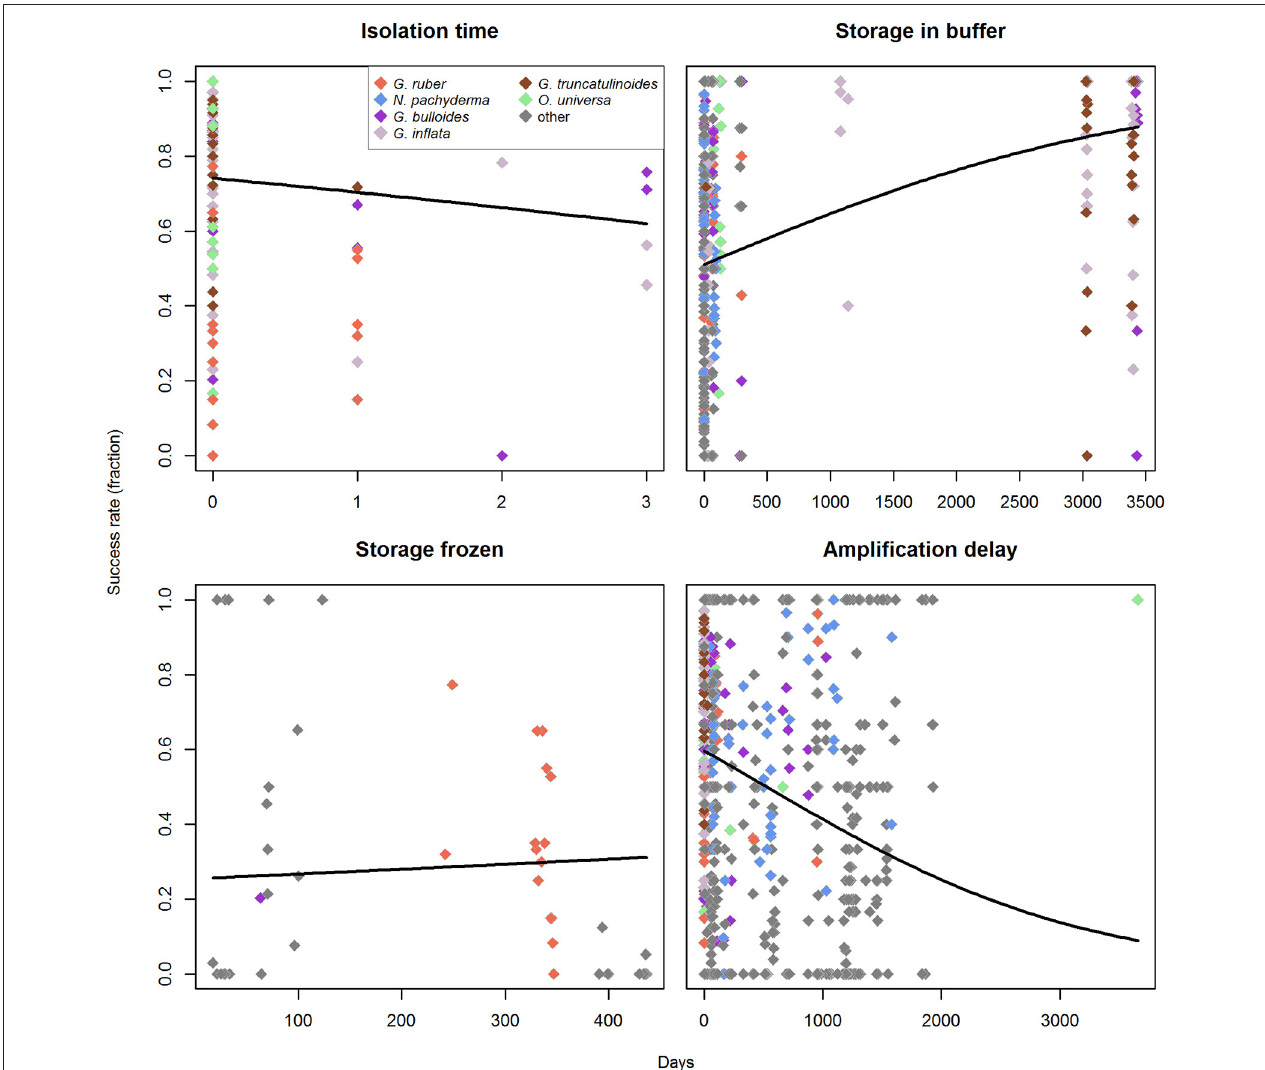
FIGURE 7 | Influence of the processing/storage times on amplification success rates in the molecular analysis of planktonic foraminifera. Regression lines represent a binomial generalized linear model with logit as link-function. The morphospecies used for the analysis of nominal factors are indicated in different colors. Zero days corresponds to the respective process being completed within 1